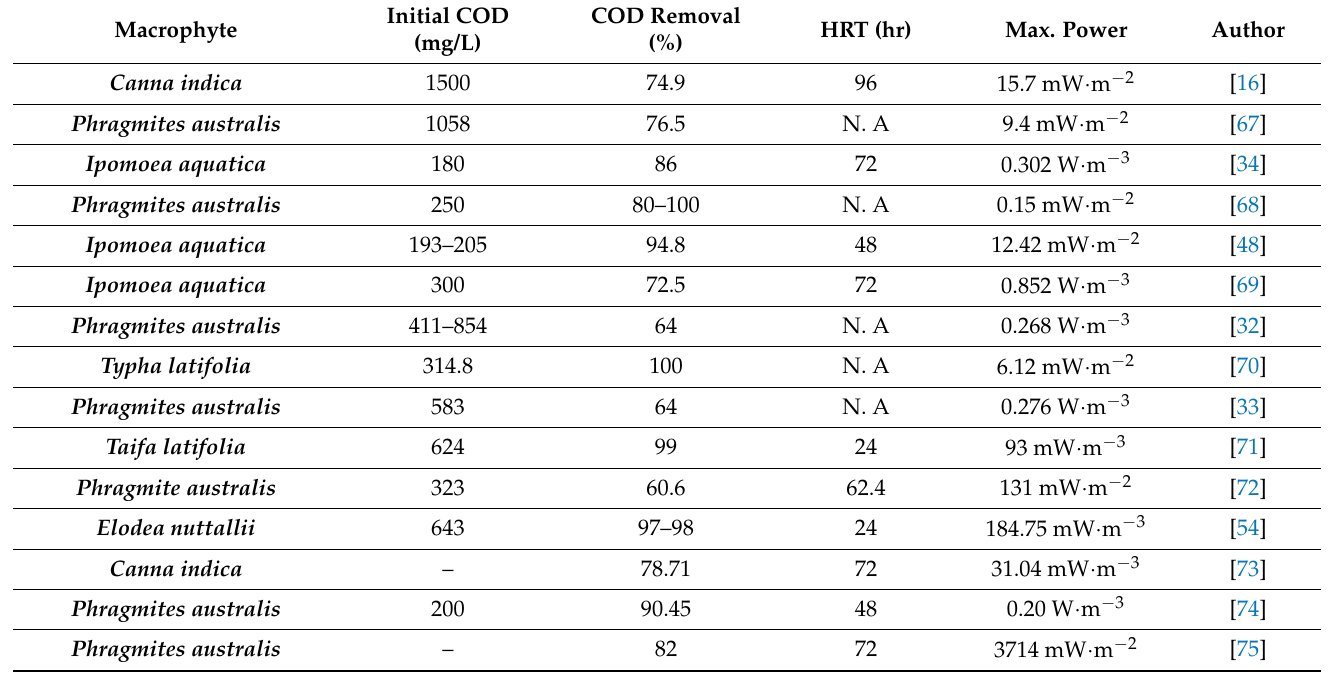
Table 1. COD removal efficiency and power density between different macrophytes based on earlier studies.